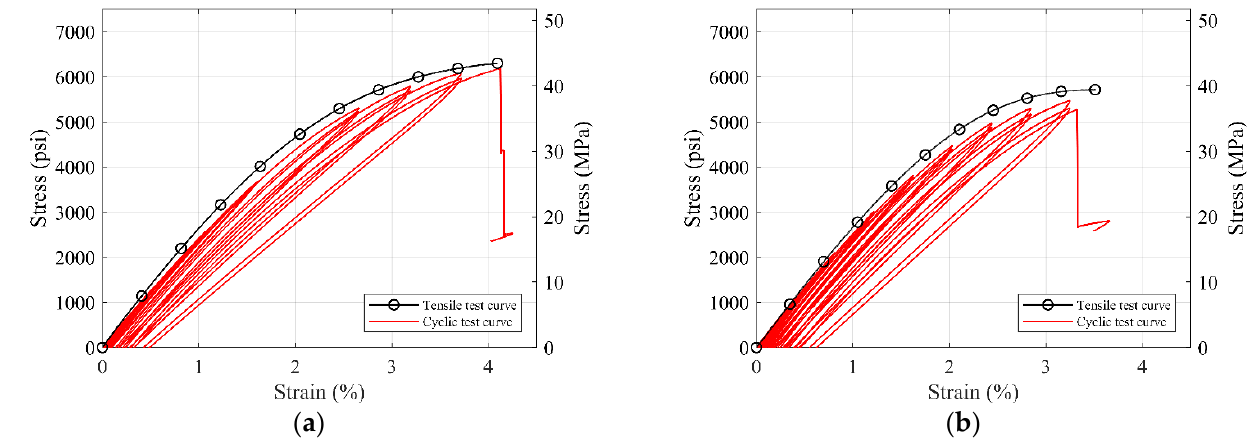
Figure 9. Average stress-strain curve for the cyclic tensile test of ( a ) S1 and ( b ) S7 material.